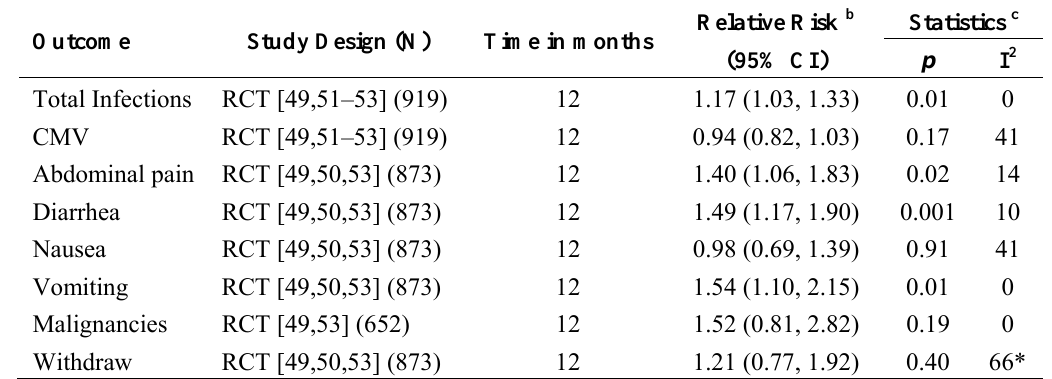
Table 3. Meta-analysis results of outcomes reported by studies comparing MMF vs. AZA a .